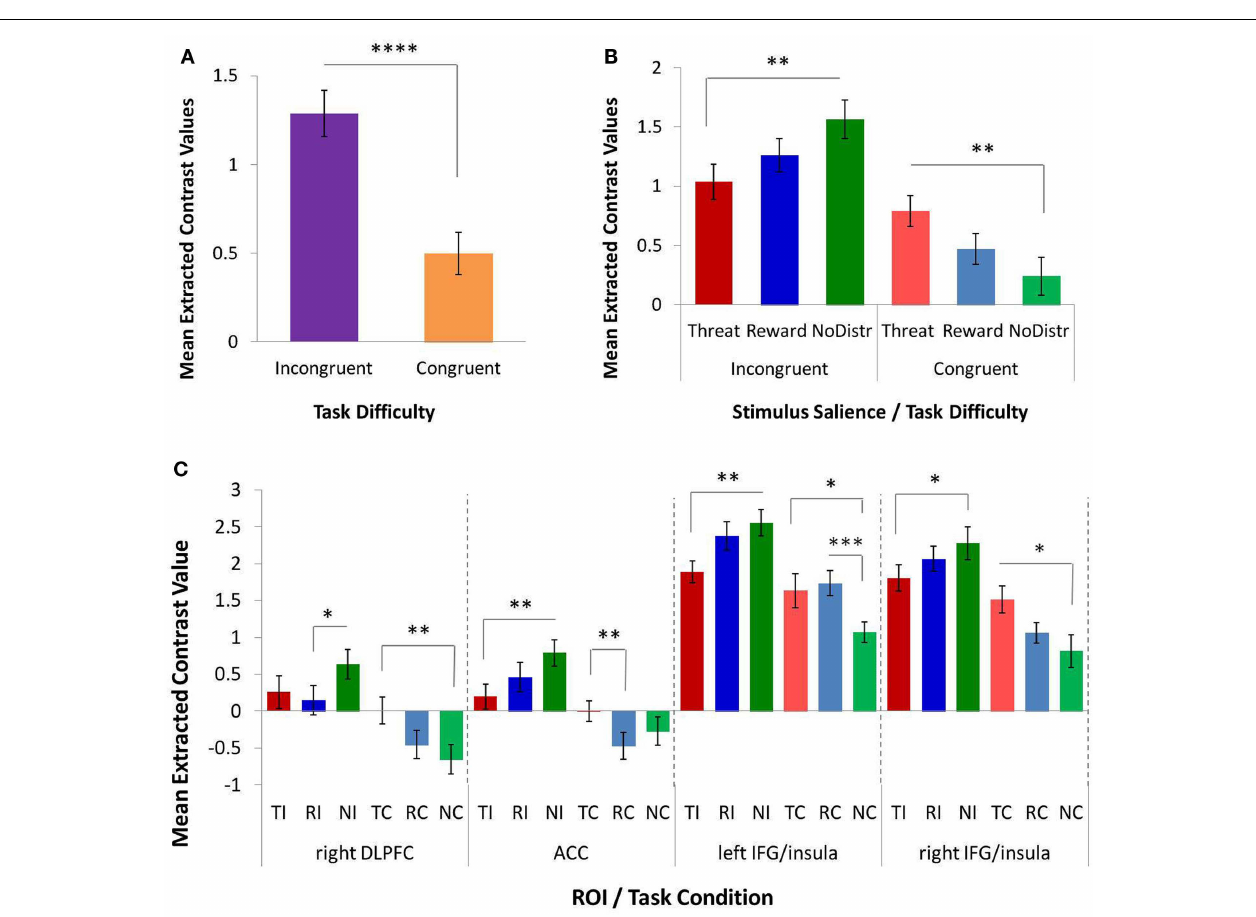
FIGURE 3 |The effects of task difficulty and stimulus salience on the response in functionally defined cognitive-control regions, as assessed with a repeated-measuresANOVA and post hoc t -tests on extracted contrast values. (A) A significant main effect of task difficulty (or MSIT condition) on the response in cognitive-control regions.The more demanding incongruent condition elicited a greater response than the easier